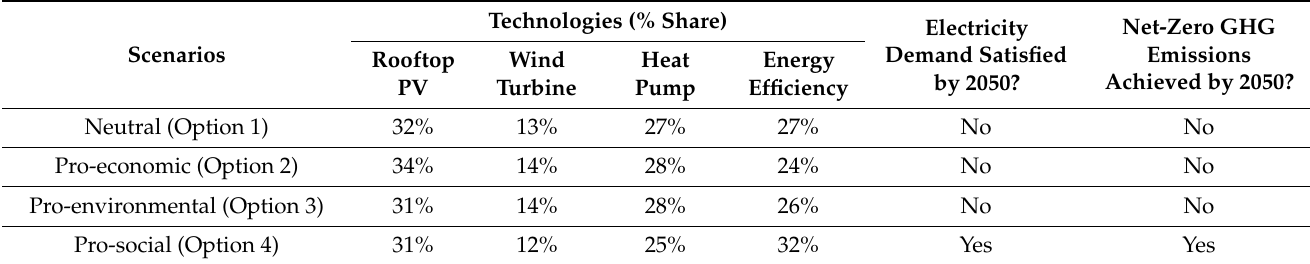
Table 10. The RE technology share options.